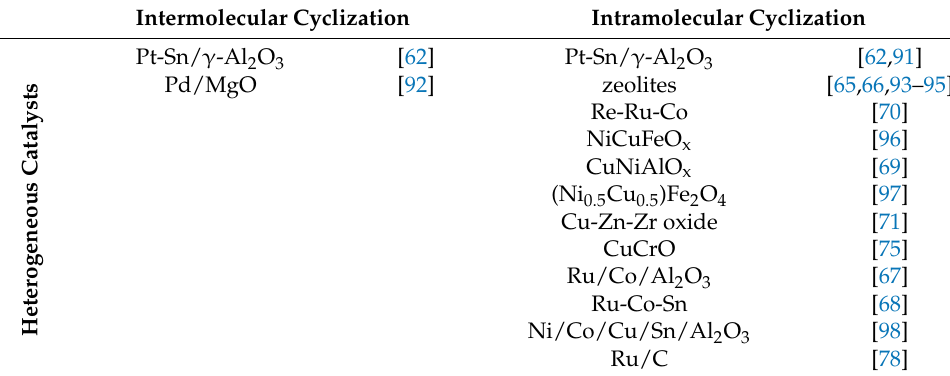
Table 5. Typical catalysts used for diol cyclization. Intermolecular